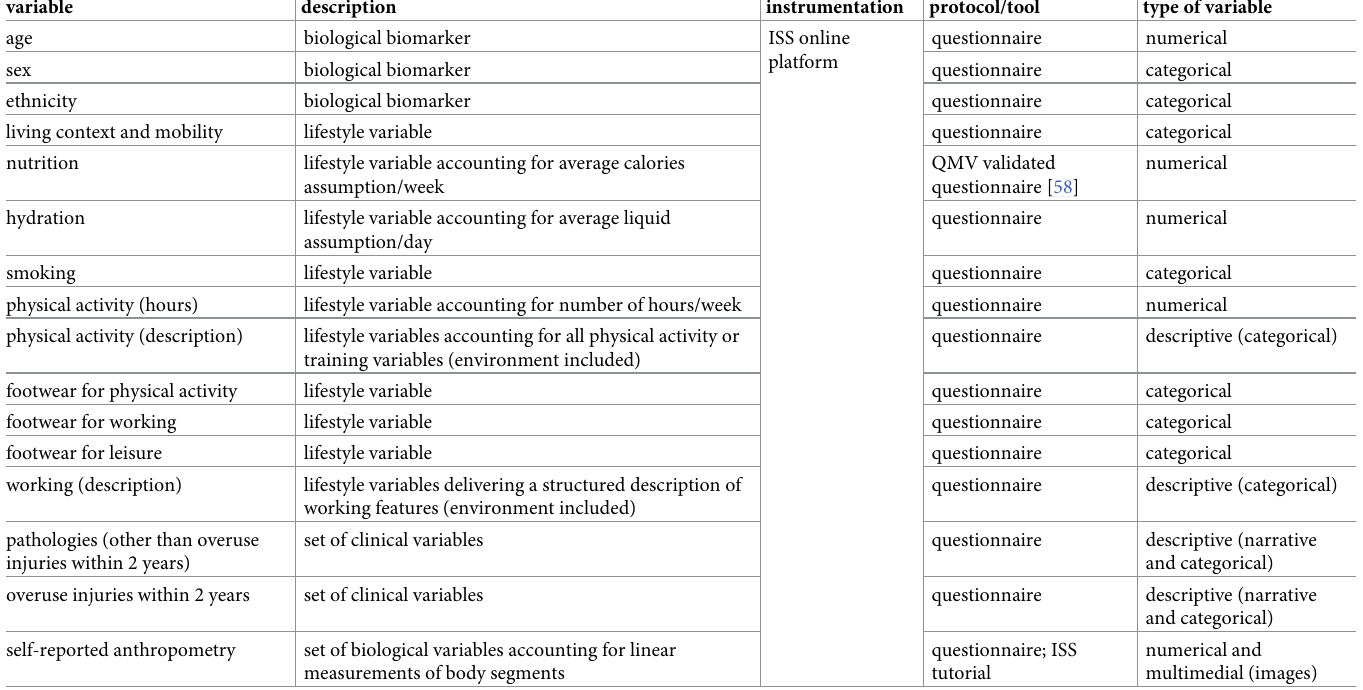
Table 1. Anamnestic and lifestyle